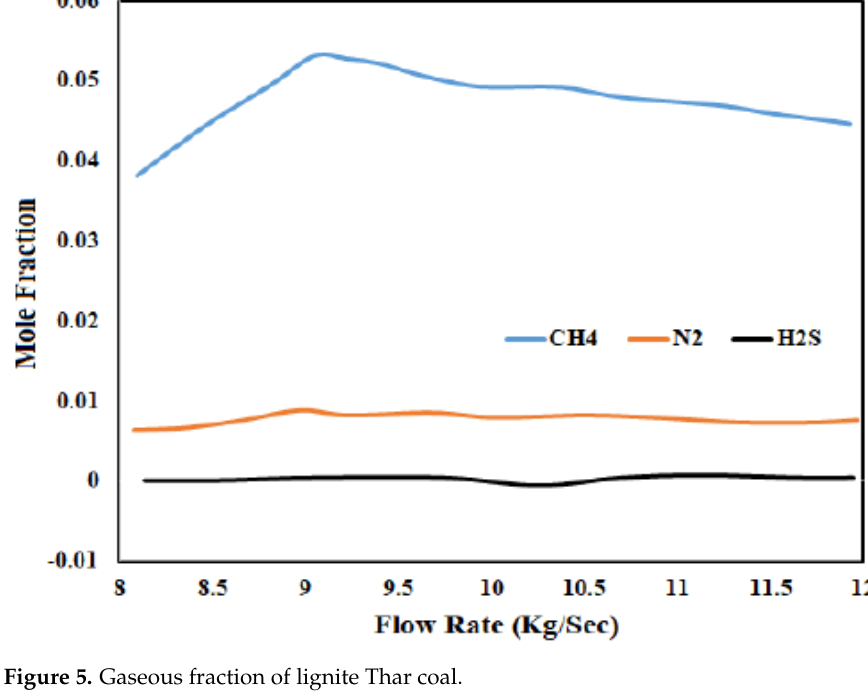
Figure 4. Syngas fraction of Thar lignite coal.